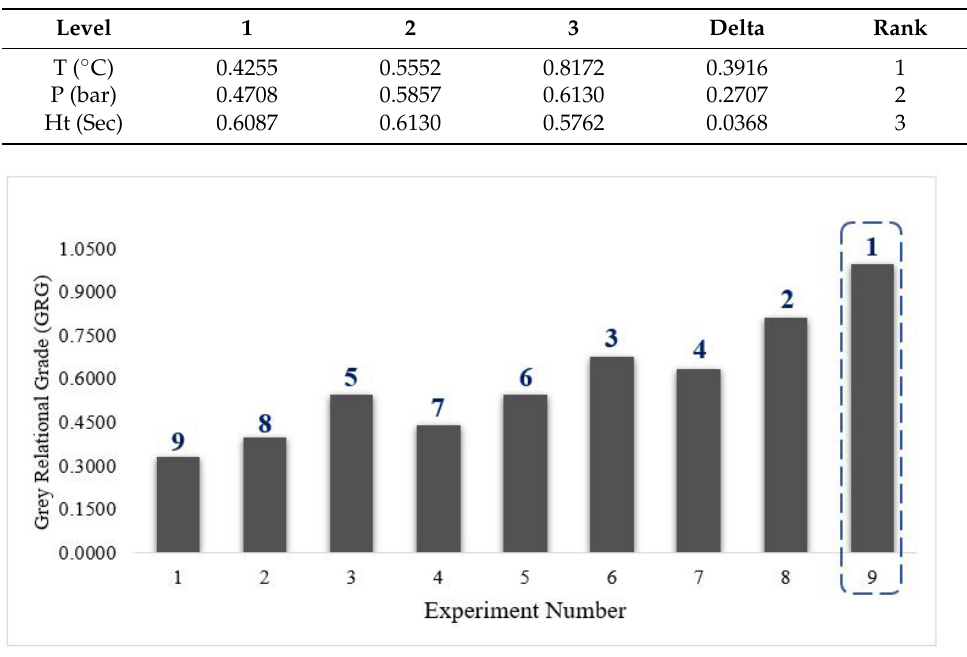
Table 8. Response table for GRG.